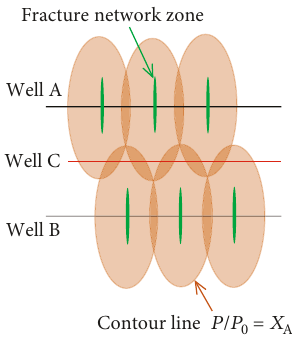
Figure 7: Pore pressure disturbance caused by the fracturing of Well A and Well B in fl uences the safe drilling of Well C. Note that the pore pressure disturbance zone overlapped within the contour line P / P 0 = X A and P / P 0 > 2 X A